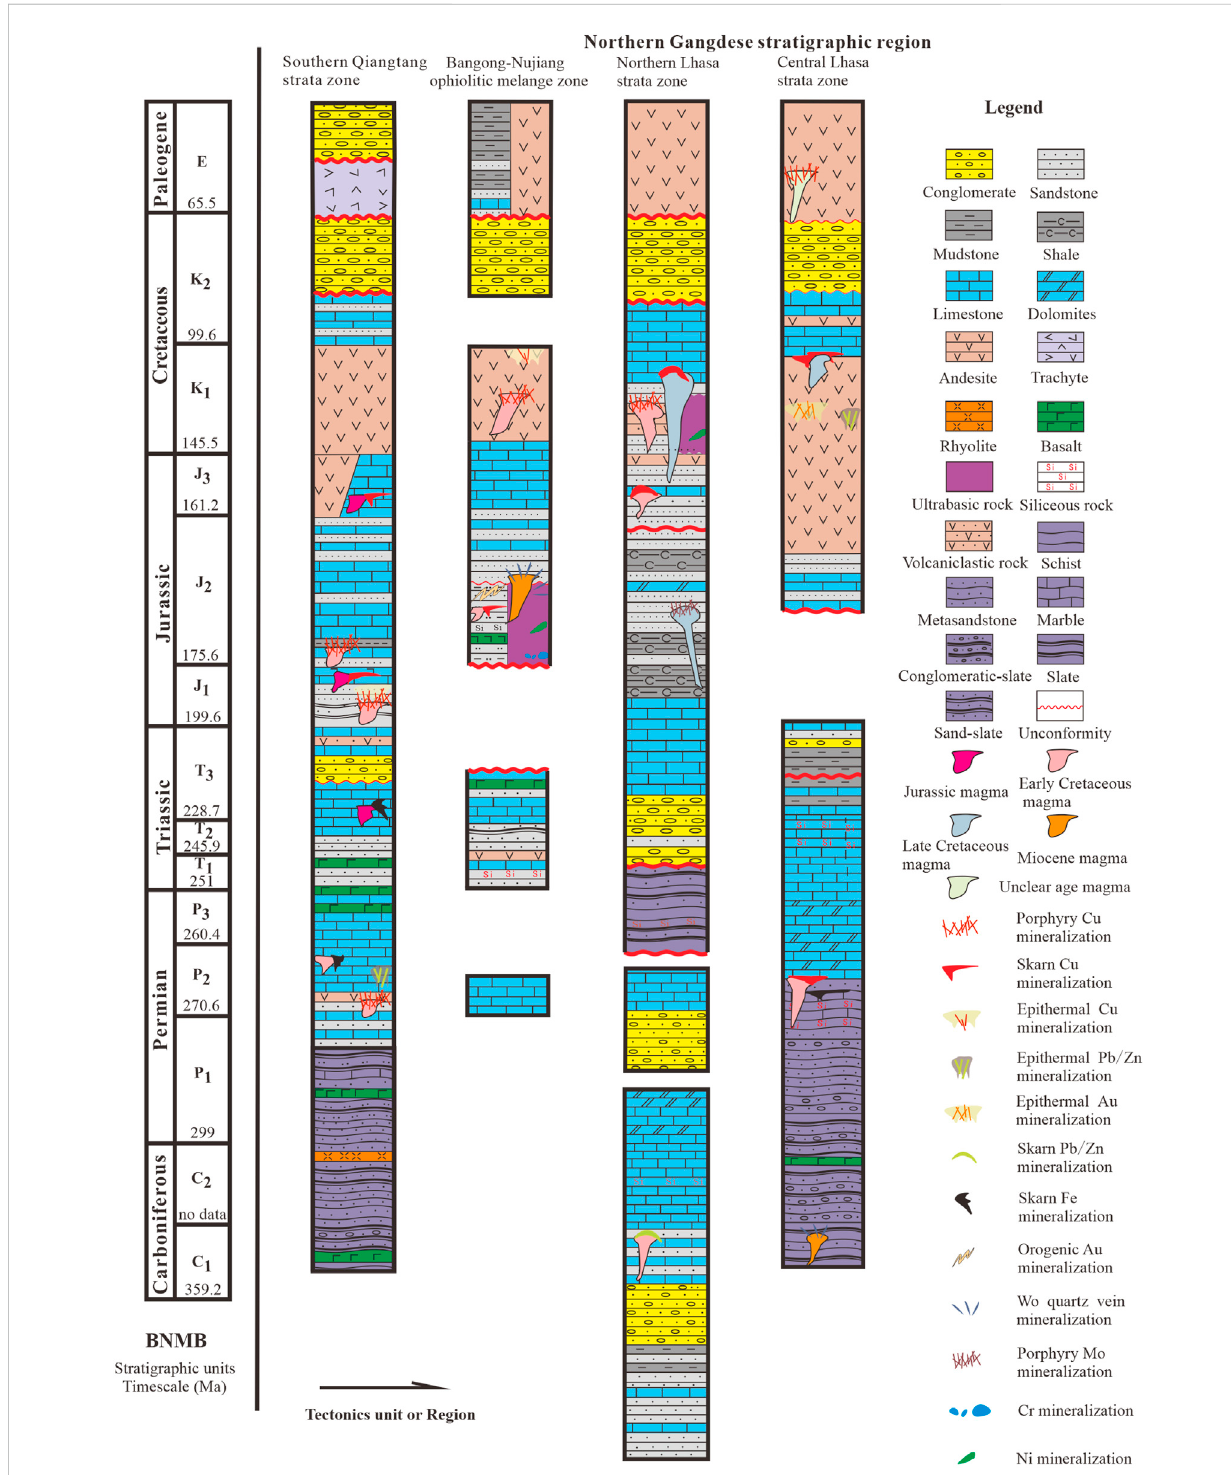
FIGURE 3 Sketch of host strata, intrusion, and ore deposit relationships in the Bangong – Nujiang metallogenic belt.